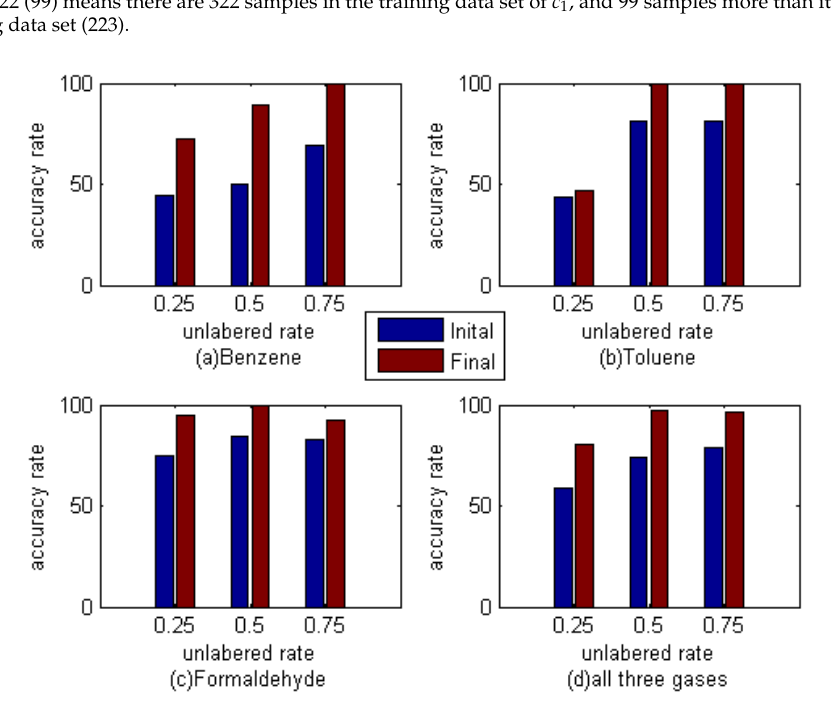
Figure 5. Classification accuracy of different gas in the test data set. ( a ), ( b ) and ( c ) show the classification accuracy of benzene, toluene and formaldehyde, respectively, and ( d ) shows the classification accuracy of all gas. In each figure, the accuracy is improved with the help of M-training, and the improvement is most obvious when the unlabeled rate is 50%.